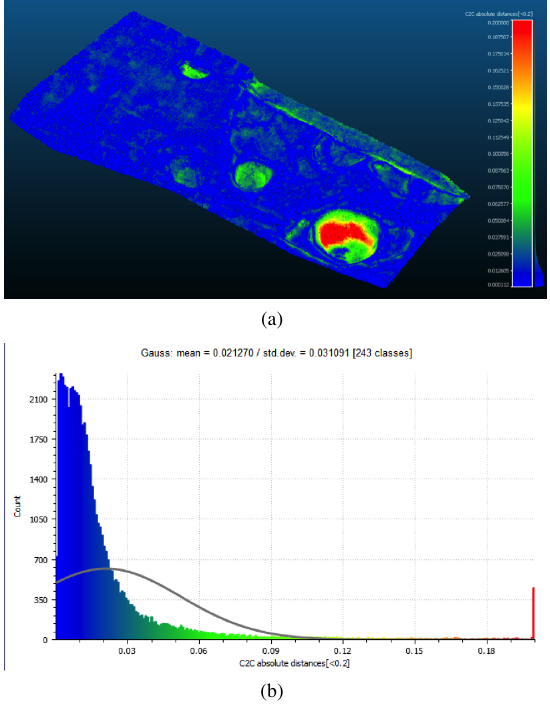
Figure 10: a) Comparison between the 2 clouds (TLS and UAV)